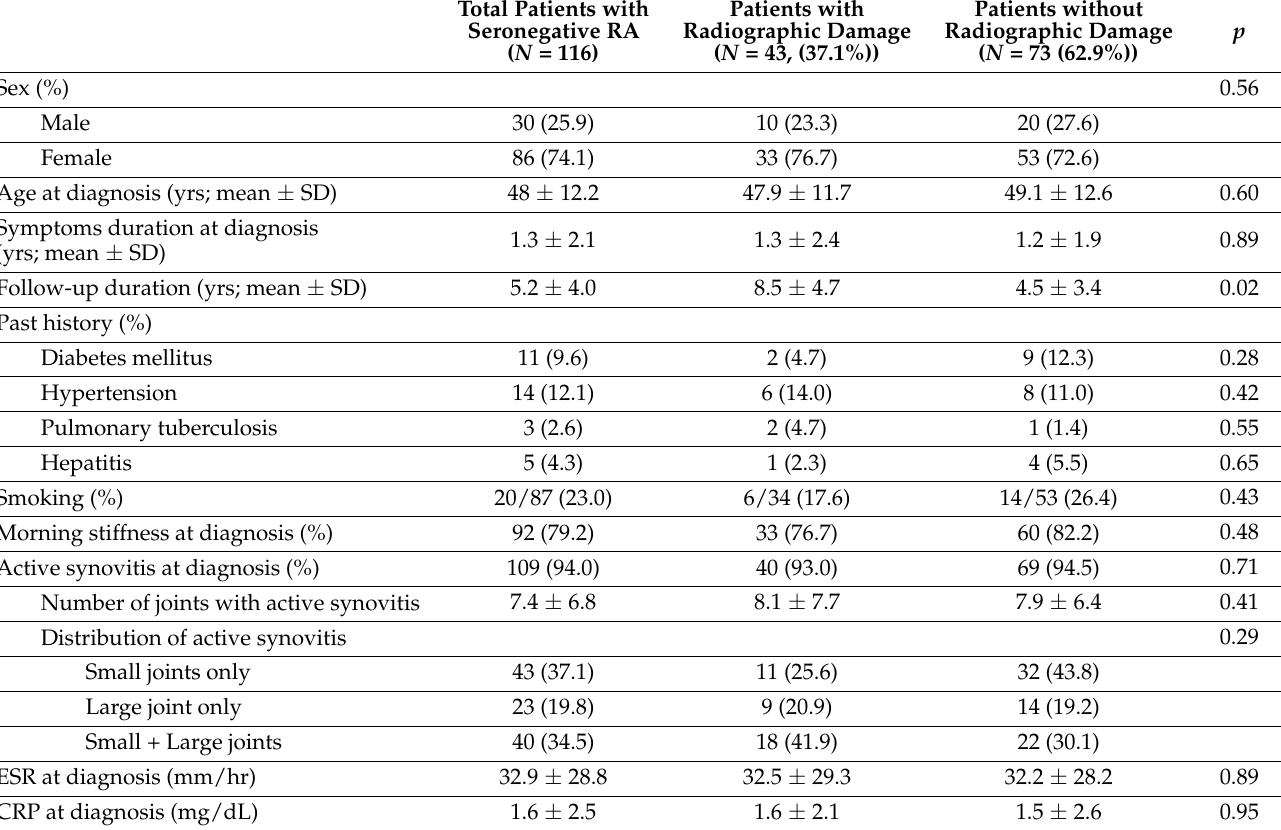
Table 1. Baseline characteristics of seronegative rheumatoid arthritis with or without radiographic damage.